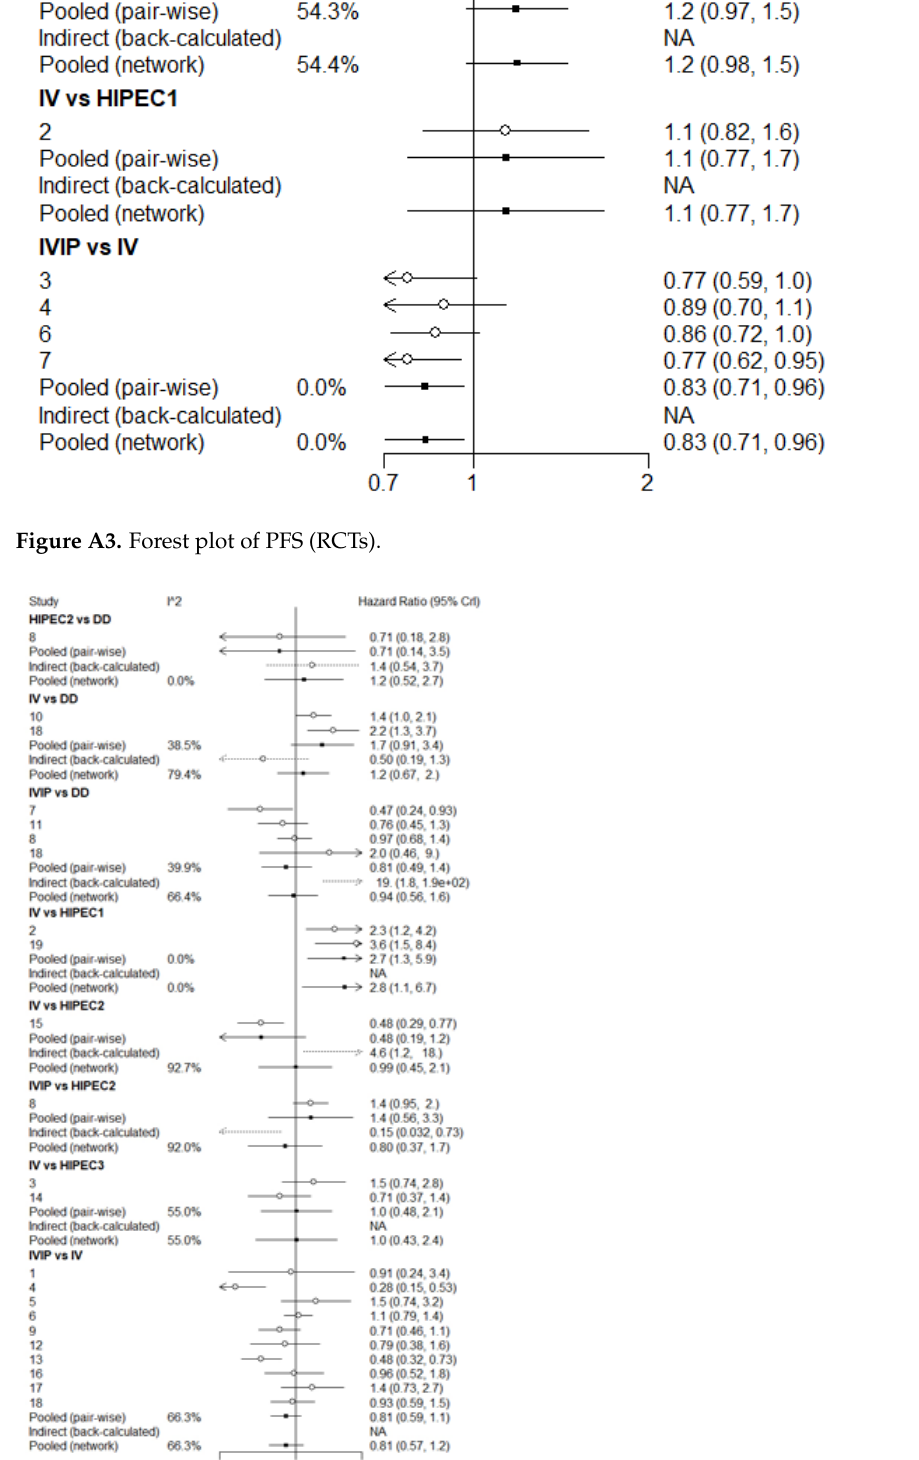
Figure A4. Forest plot of PFS (non ‐ RCTs).